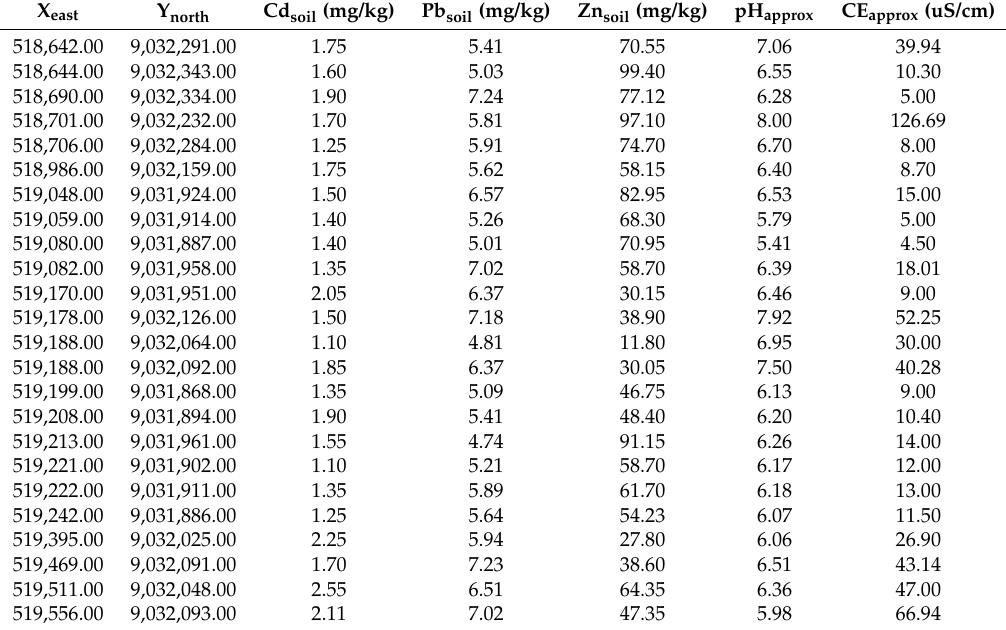
Table 2. Average concentration in soils of: Cd, Pb, Zn, pH and electrical conductivity.